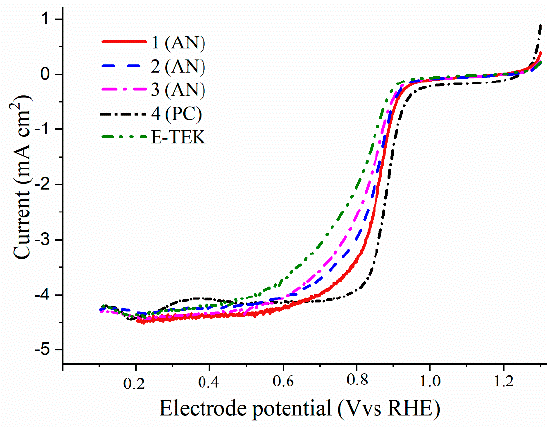
Figure 2. CV curves of Pt / Cu and Pt catalyst modified RDE electrode in oxygen-saturated 0.2 M NaOH electrolyte, 1000 rpm (catalyst samples differs by platinum loading and template preparation solvent; description of the samples is given in Table 1).